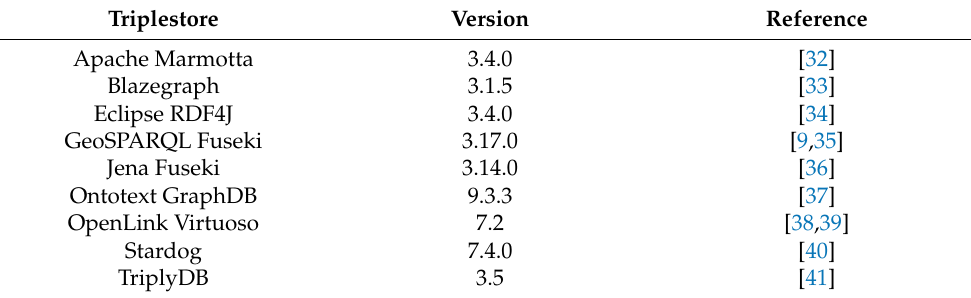
Table 1. Triplestores which have been tested using the GeoSPARQL compliance